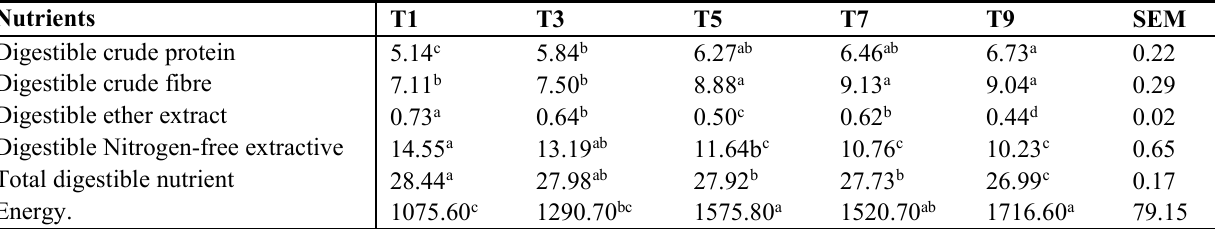
Table 5. Effects of concentrate supplement-feeding regimes on percentage digestible nutrients and total digestible nutrient (TDN) of